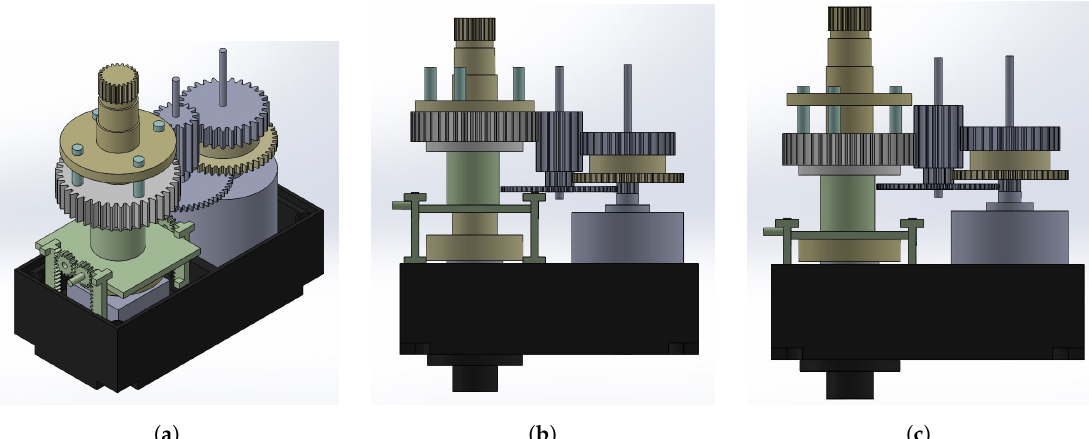
Figure 2. Stiffness control of the elastic actuator by clutch length. ( a ) Solid model, ( b ) Minimum clutch length (rigid), ( c ) Maximum clutch length (maximum elastic).